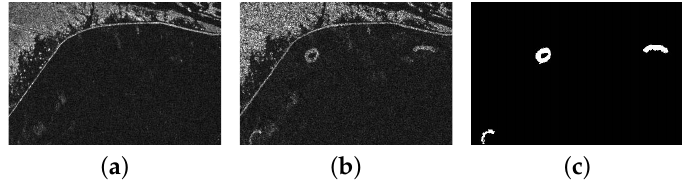
Figure 12. Multitemporal images relating to the coastline of the Yellow River Estuary and the reference image. ( a ) Image acquired in June 2008. ( b ) Image acquired in June 2009. ( c ) The reference